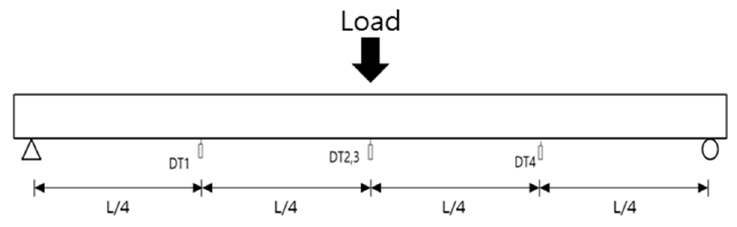
Figure 5. Displacement transducer (DT) positions (NSM and EP methods).